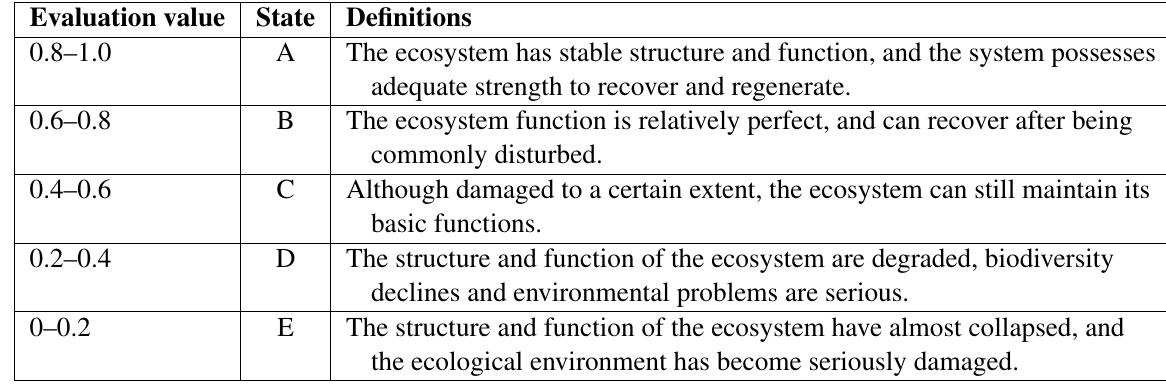
Table 8 Classification of state